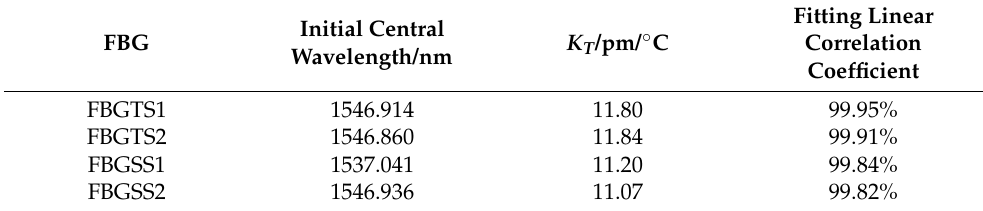
Table 3. The temperature sensitivity constants of the four FBGs.